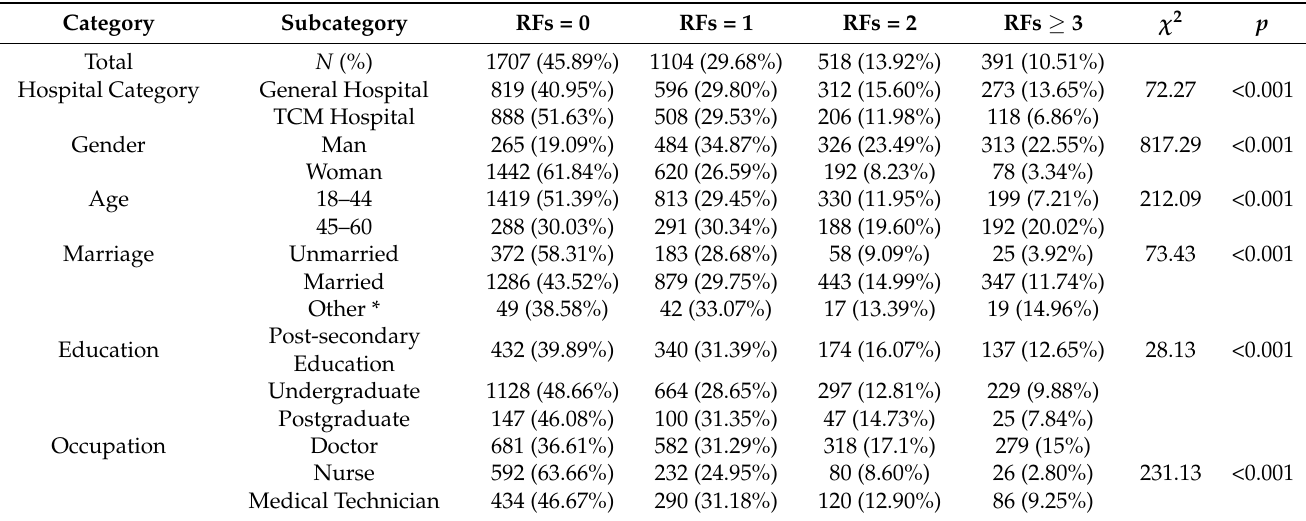
Table 3. The prevalence with different numbers of CVD risk